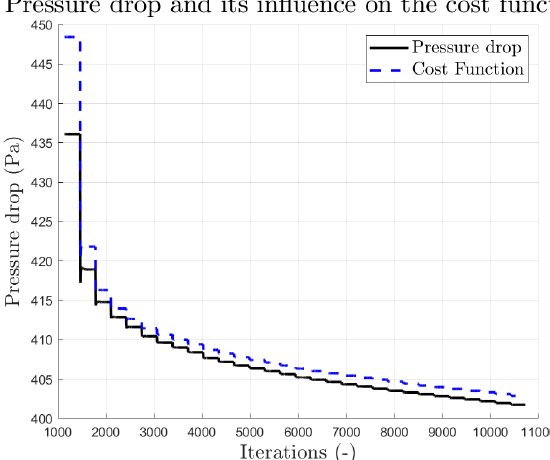
Figure 13. Pressure drop minimization.